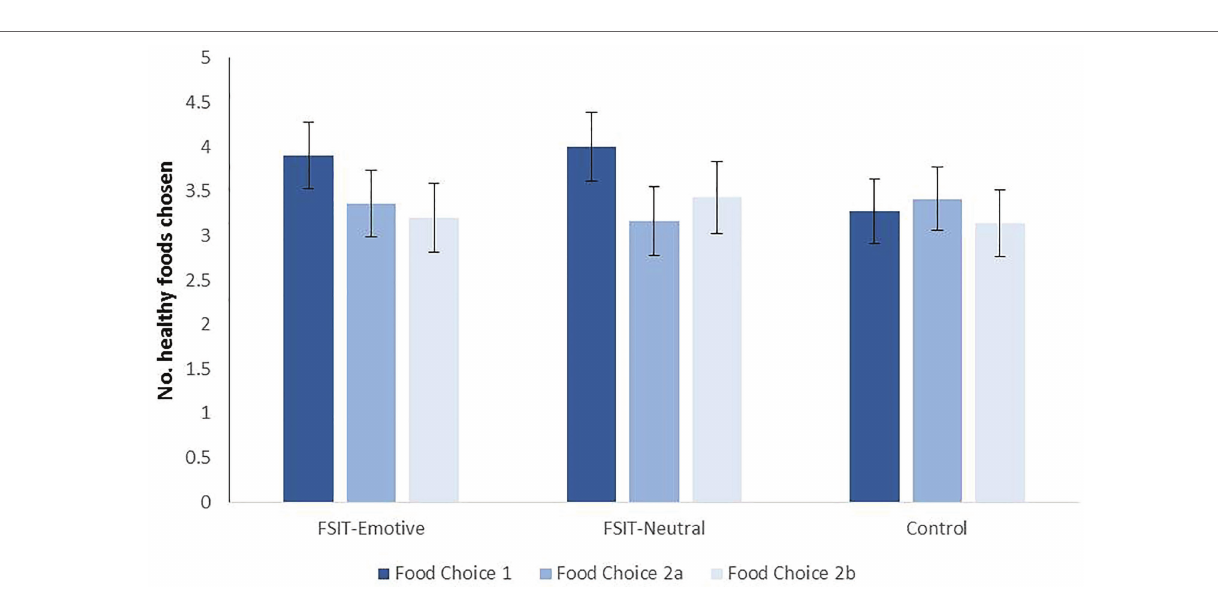
FIGURE 2 | Mean number of healthy-foods chosen at each time-point for each condition, with SE. Food Choice 1 occurred immediately post-training in Session 1, 2a occurred 1 week later before the top-up training and 2b occurred immediately after the top-up